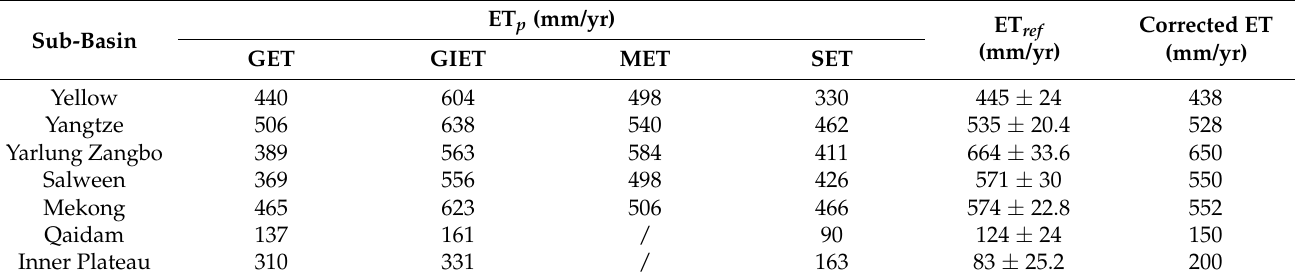
Table 5. The comparison of the average annual ET p , ET ref , and corrected ET of the sub-basins.